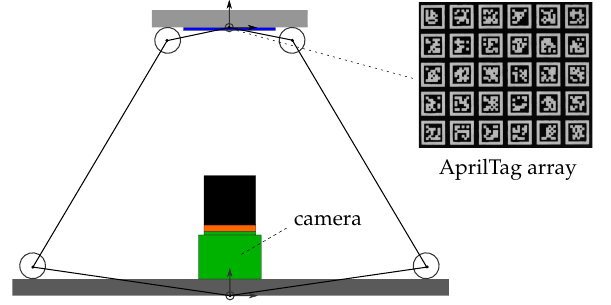
Figure 4. Vision-based concept for pose detection: Side view of a parallel mechanism with a camera on the base platform and an AprilTag array on the bottom side of the manipulator